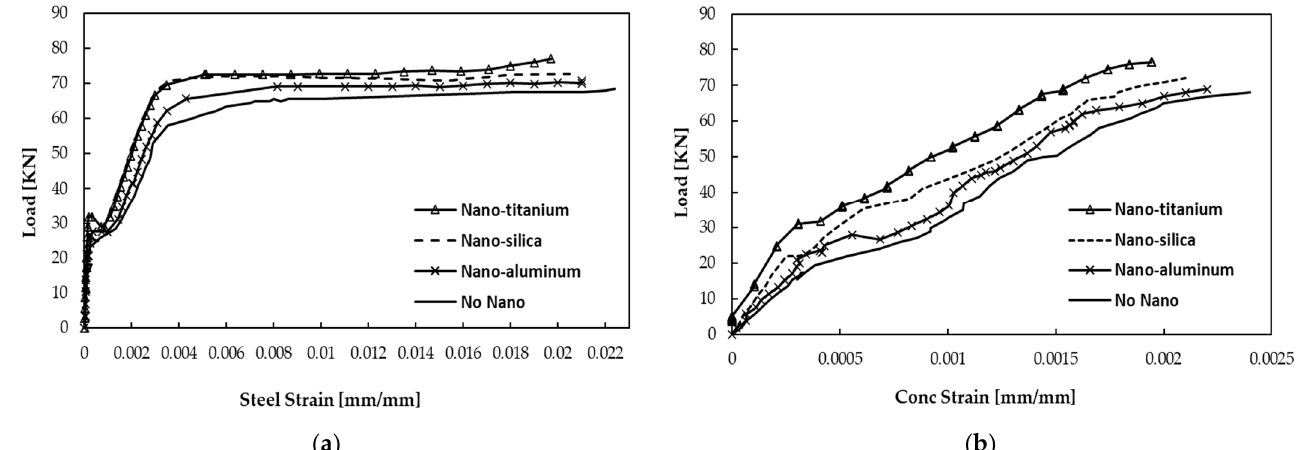
Figure 5. Load strain curves for all tested beams: ( a ) load ‐ tensile steel strain, and ( b ) load ‐ concrete compressive strain.